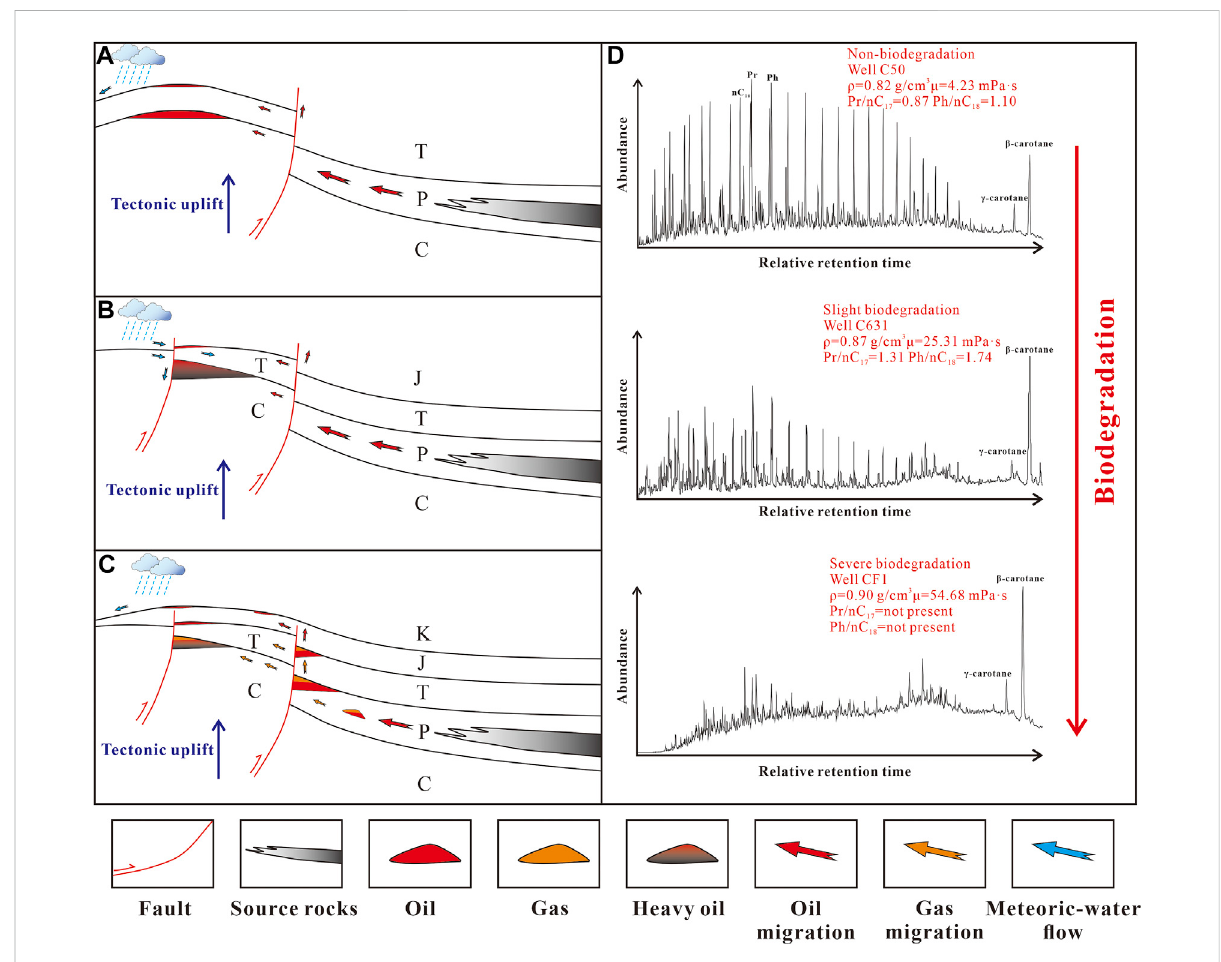
FIGURE 13 Accumulation model for volcanic reservoirs in the Hongche fault zone in different geological periods and gas chromatograms of crude oil under different degrees of biodegradation. (A) Late Triassic oil and gas accumulation model; (B) Late Jurassic oil and gas accumulation model; (C) Early Cretaceous oil and gas accumulation model; (D) Gas chromatograms of crude oil under different degrees of